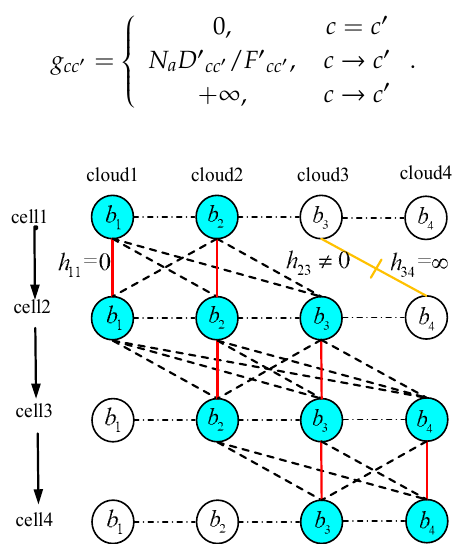
Figure 7. The schematic diagram of graph theory.